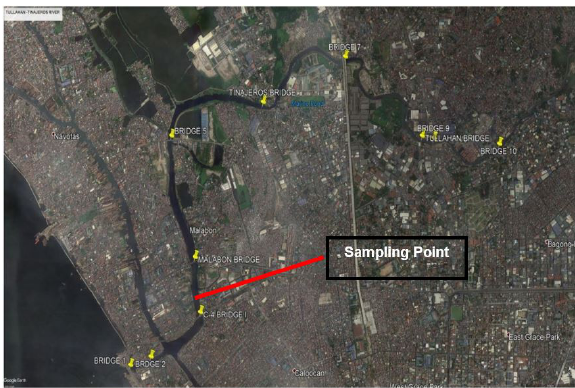
Fig. 1. Tullahan-Tinajeros River System